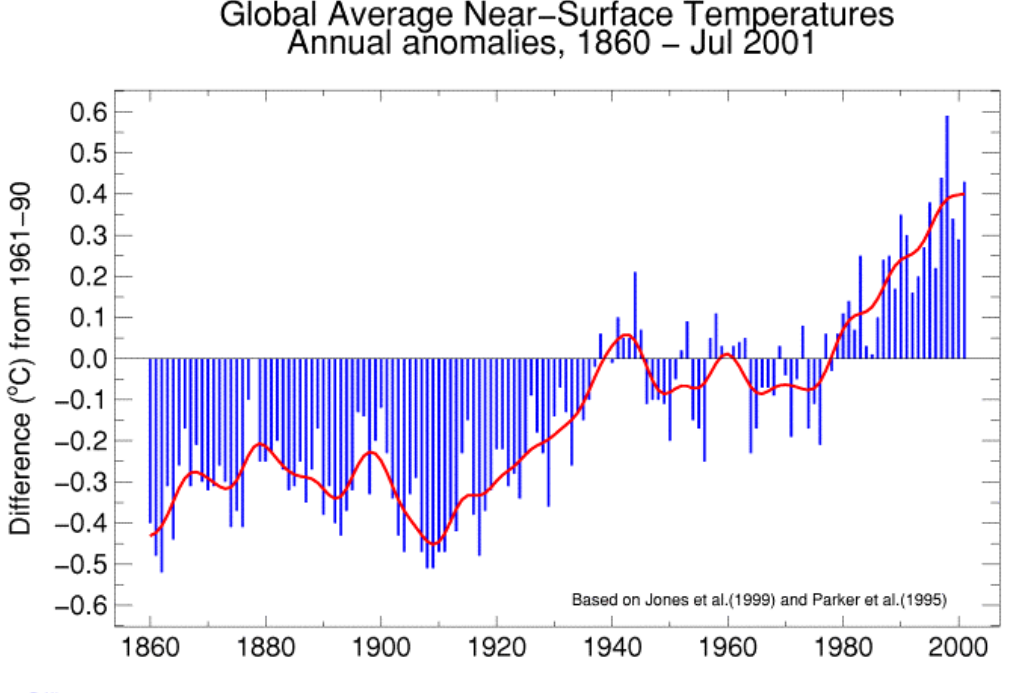
FIGURE 2. Global average annual surface temperature anomalies 1860–June 2001. (From UKMet Office, Hadley Centre for Climate Prediction and Research. With permission.)